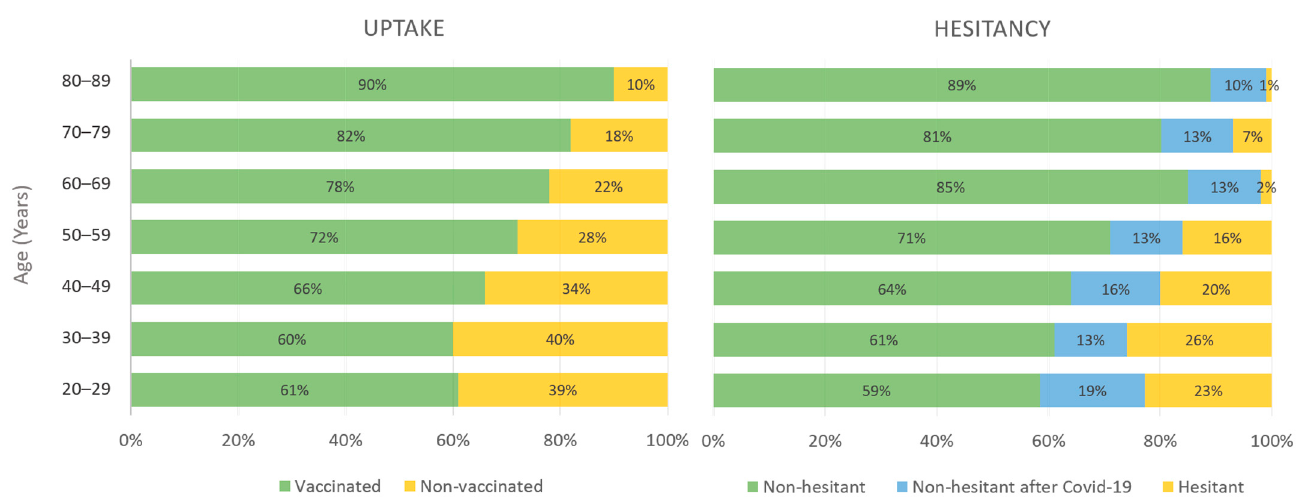
Figure 1. COVID-19 vaccine uptake on 6 September 2021 [23] versus COVID-19 vaccine hesitancy in March 2021 per age group in South Tyrol.